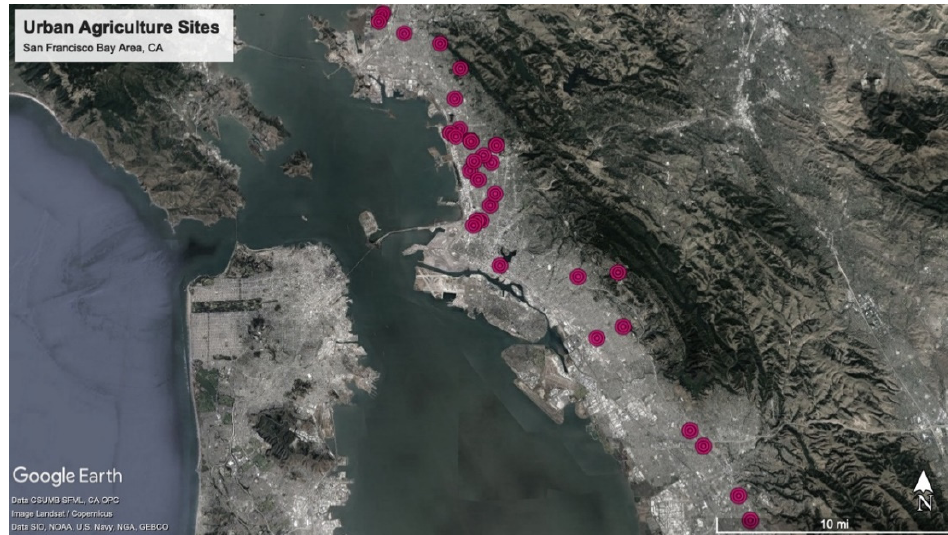
Figure 1. Urban farm study sites ( n = 29